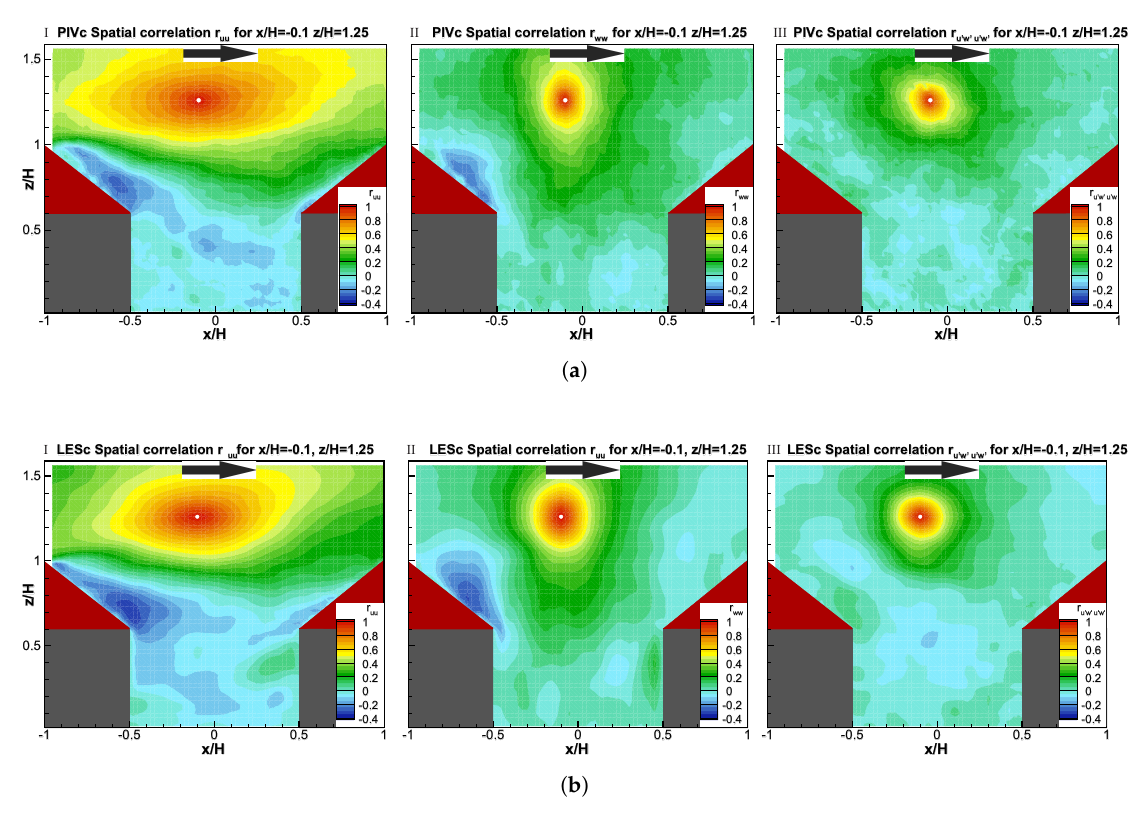
Figure 10. Spatial correlation of the normalised streamwise velocity fluctuation r uu (first column), of the vertical velocity r ww (second column) and of the fluctuation of the momentum flux r u (cid:48) w (cid:48) u (cid:48) w (cid:48) (third column) for the chosen point at x / H = 0, z / H = 1.25 for ( a ) PIVc and ( b ) LESc. The LES plot is interpolated onto the PIV grid (4977